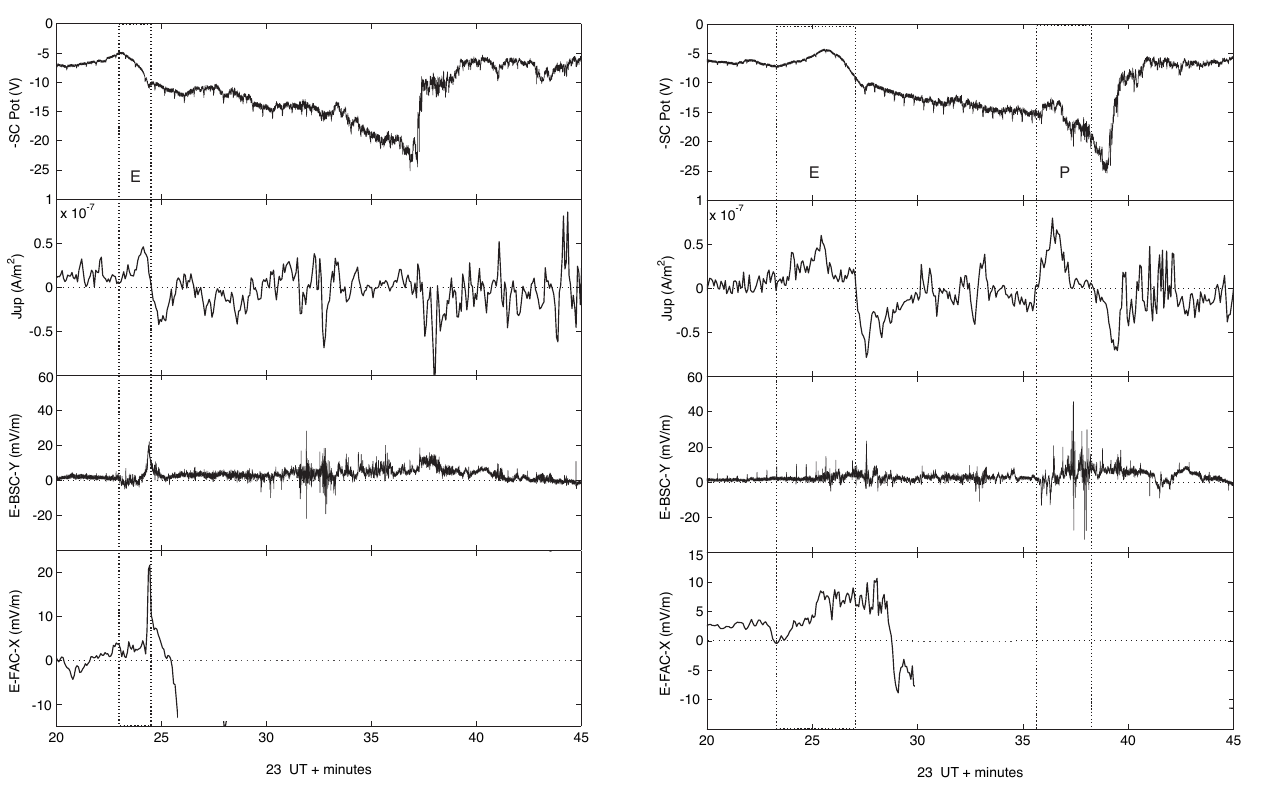
Fig. 6. As Fig. 5, but for